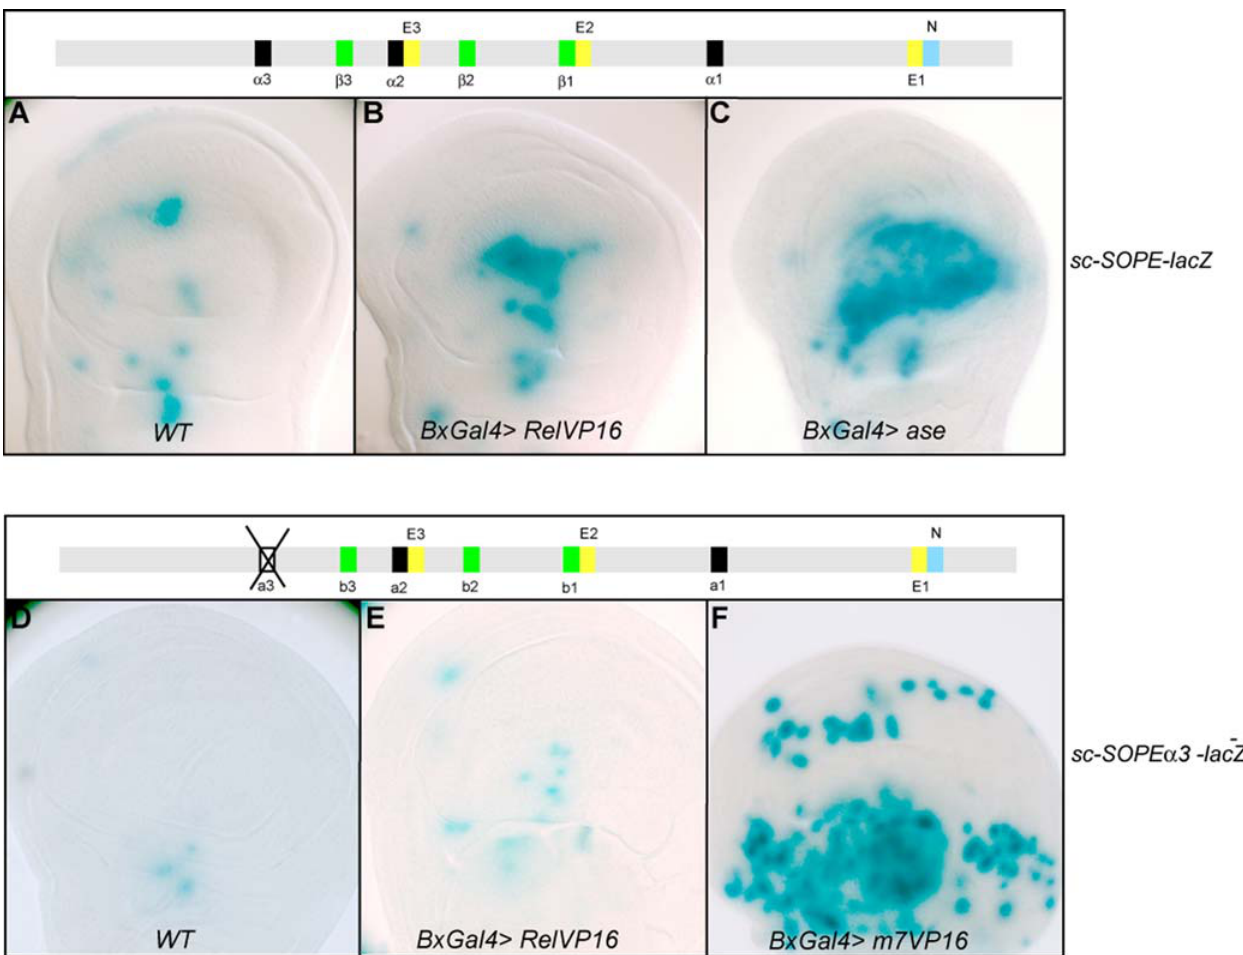
Figure 4. A protein composed of a fusion of Relish and VP16 can bind to the scuteSOP-enhancer and activate transcription invivo. (A–C), expression of sc-SOPE-lacZ in wild type (A), Bx-Gal4 . UAS-RelVP16 (B) and Bx-Gal4 . UAS-ase discs (C). Over-expression of asense results in activation of the reporter gene over a larger area than over-expression of RelVP16 . (D–F), expression of sc-SOPE a 3 2 -lacZ (a version of the enhancer construct in which one of the NF- k B/Rel binding sites, a 3 , has been mutated) in wild type (D), Bx-Gal4 . UAS-RelVP16 (E) and Bx-Gal4 . UAS-E(spl)m7VP16 (F) discs. Expression is decreased in wild-type flies and after over-expression of RelVP16, but strongly increased in the presence of E(spl)m7VP16 whose activity does not rely on the same binding